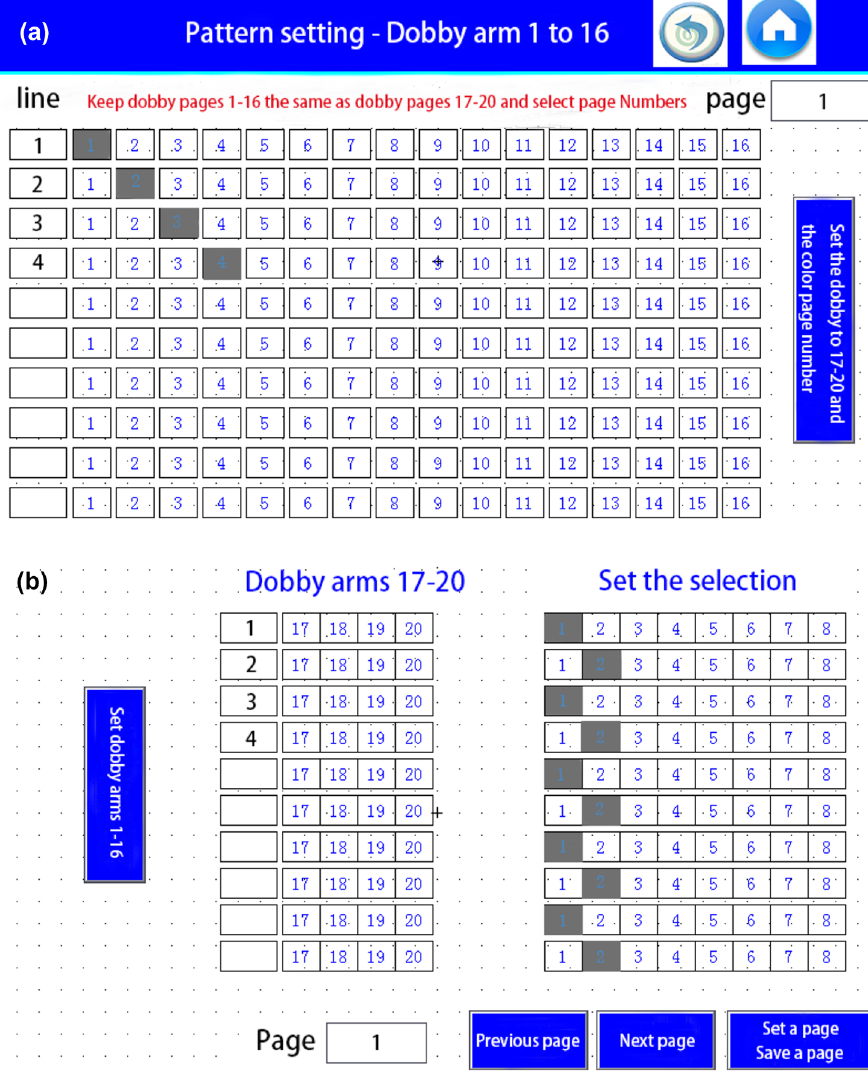
Fig. 22 a The first part of the design color interface; b the second part of the design color